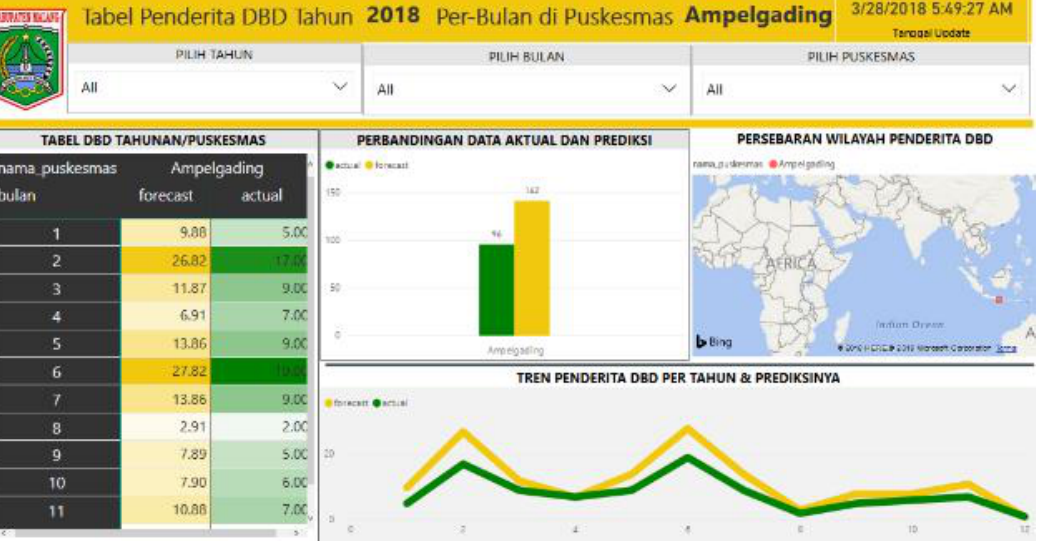
Fig. 8 Dengue Fever Patient Trends Per Year and Predictions 2 Monthly Pastient